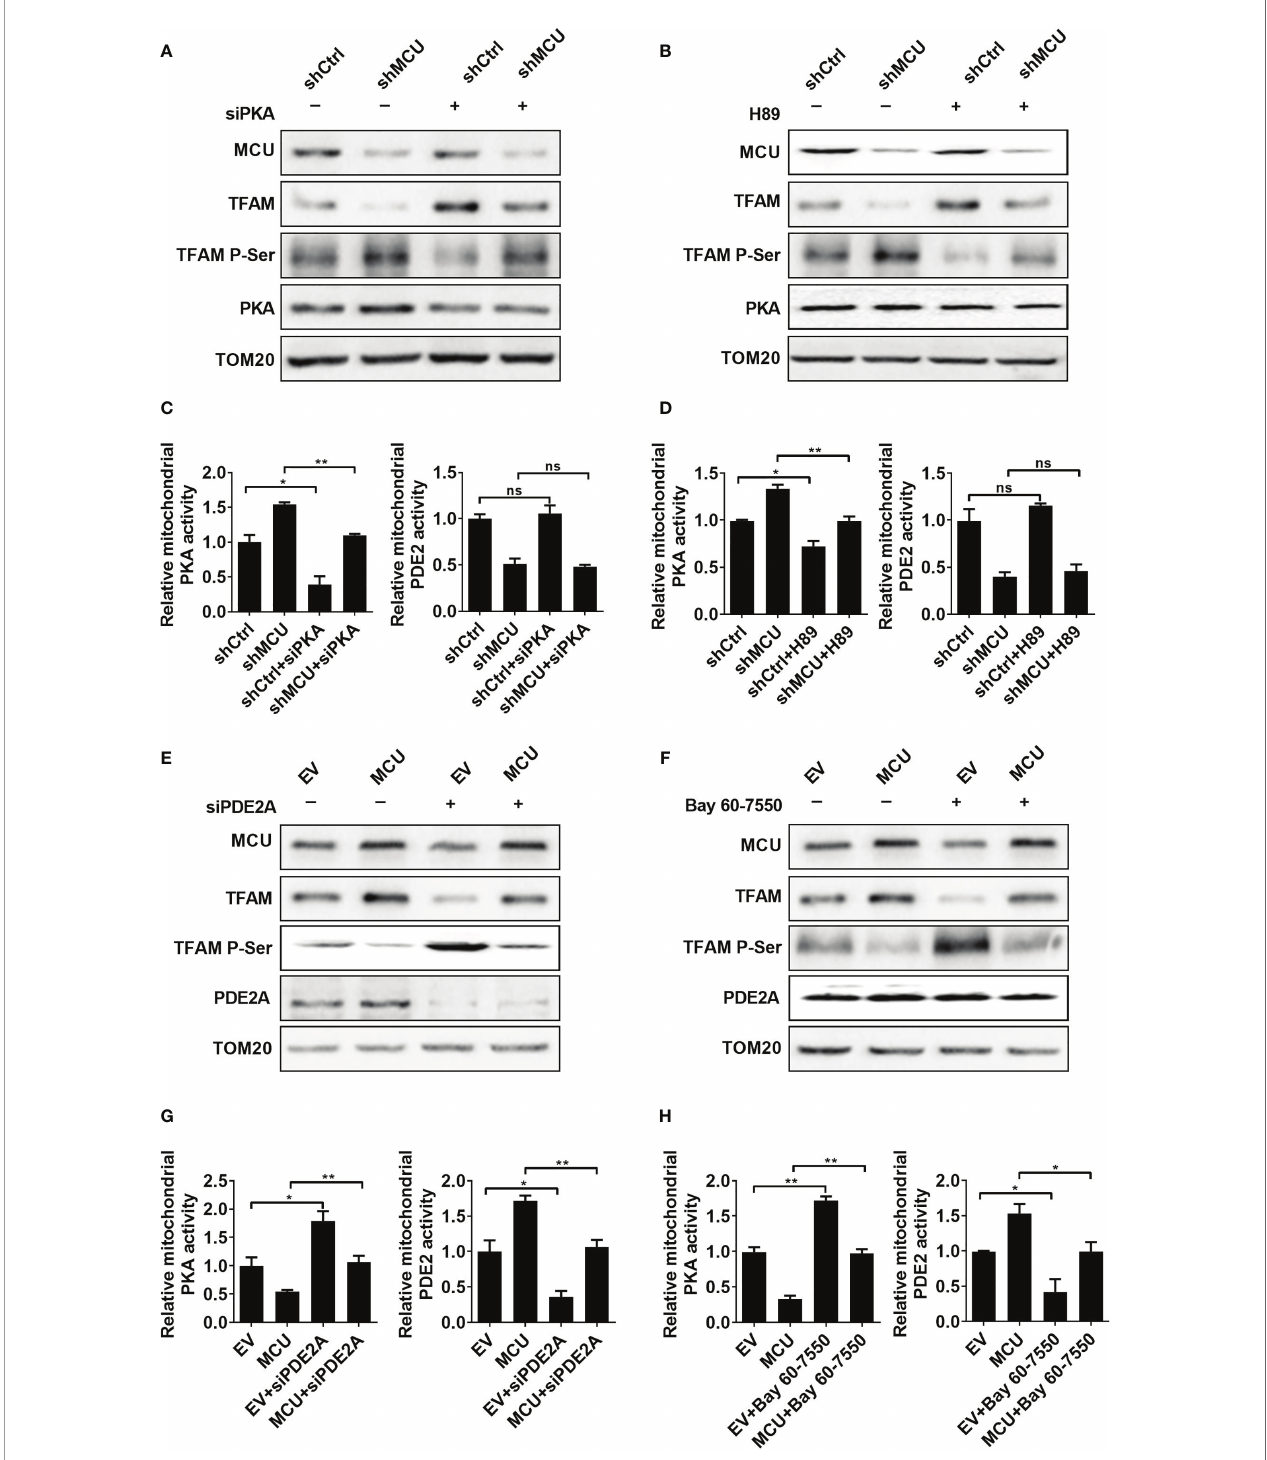
FIGURE 2 | PDE2-mediated inhibition of PKA activity is essential for mitochondrial Ca2+ induced dephosphorylation of TFAM. (A, B) Western blot analysis for protein levels of mitochondrial MCU and PKA, TFAM and phosphorylated TFAM in LS174T cells treated as indicated. siPKA: siRNA against PKA. PKA inhibitor H89 (1 m M) was used. (C, D) Relative activities of mitochondrial PDE2 and PKA in LS174T cells treated as indicated. (E, F) Western blot analysis for protein levels of mitochondrial MCU, PDE2, TFAM and phosphorylated TFAM in LS174 cells treated as indicated. (G, H) Relative activities of mitochondrial PDE2 and PKA in LS174T cells treated as indicated. siPDE2A: siRNA against PDE2A. PDE2 inhibitor Bay 60-7550 (4.7 nM) was used. *P < 0.05; **P < 0.01; ns, not signi fi